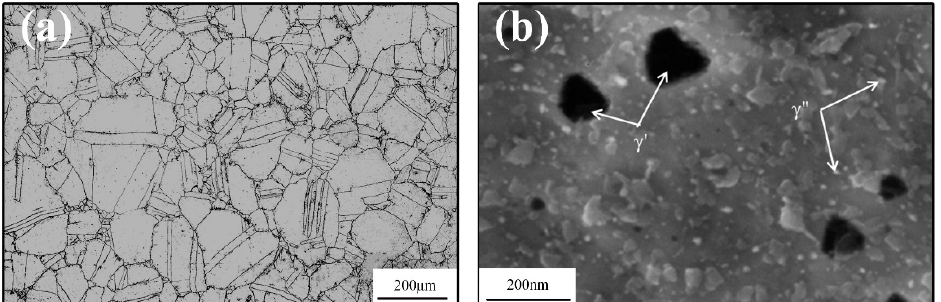
Figure 1. Initial microstructure of superalloy GH4169: ( a ) the grain microstructure; ( b ) the γ′′ and γ′ phases.